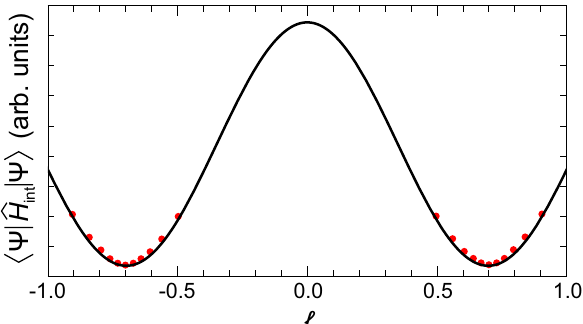
Figure 5. Approximation of the interaction energy. The parametric dependence of the interaction energy � (cid:31) | ˆ H int | (cid:31) � on OAM of the polariton condensate driven by supplemental rotation. Red dots indicate solutions of Eq. (17) with the Hamiltonian ̂ H 0 supplemented with the rotation term �𝜔 rot ̂ L ̌𝜎 0 . The black curve is the fit with the function cos ( 𝜁𝜃 ) . The shift of the pump spot is taken r p = 1.1 μ m , the polarization of the pump is linear ( p = 0